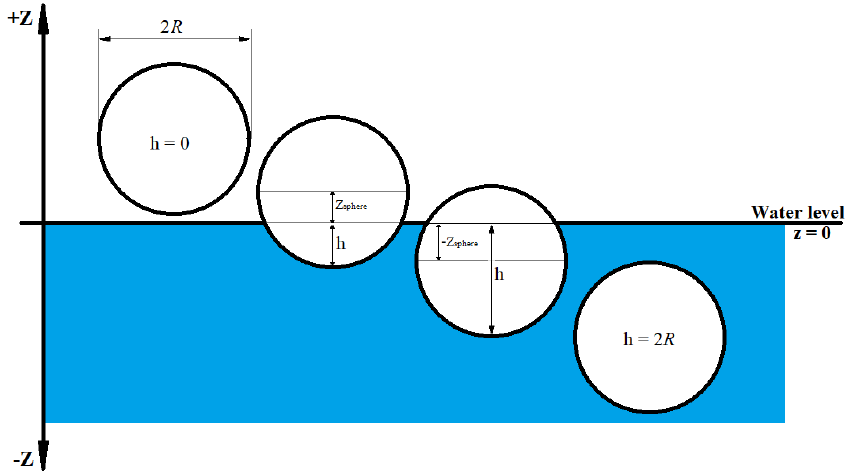
Figure 2. Explicative diagram of the under water volume of the sphere.